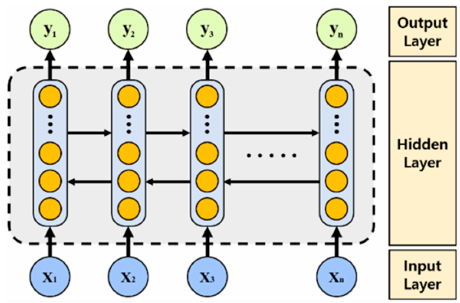
Figure 3. Bidirectional LSTM Network Information Sharing.